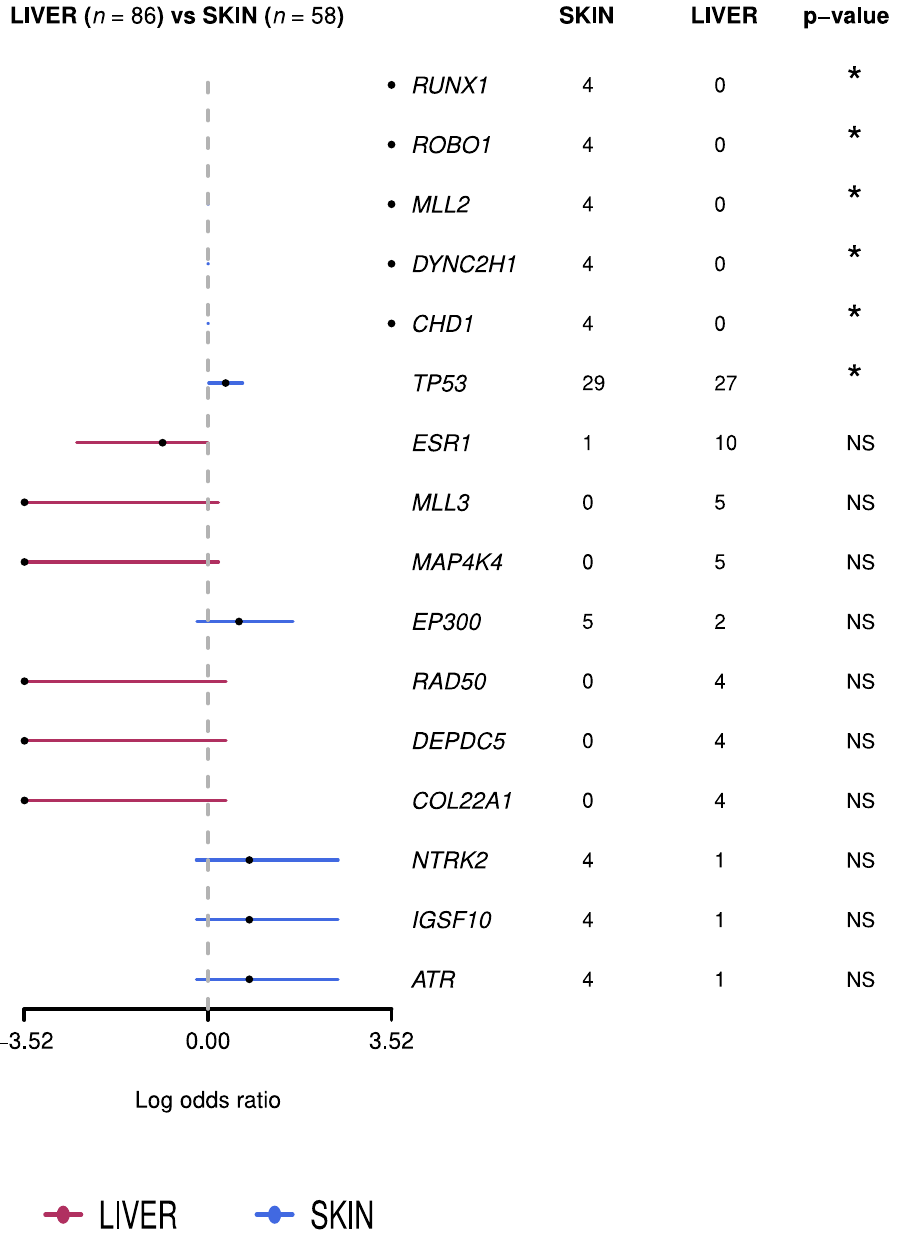
Figure 8. Genes differentially mutated in liver and skin metastases (* statistically significant differences). The red lines reflect a higher frequency of mutation in genes in the liver metastases with respect to the skin metastases, with no statistically significant differences, and the blue lines reflect a higher frequency of mutation of genes in the skin metastases with respect to the liver metastases, with no statistically significant differences.